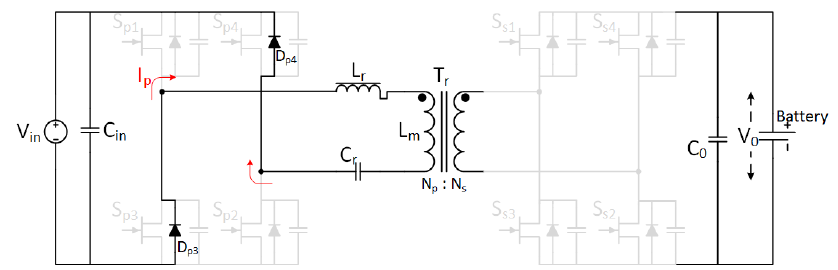
Figure A4. LLC resonant converter topology interval-4.